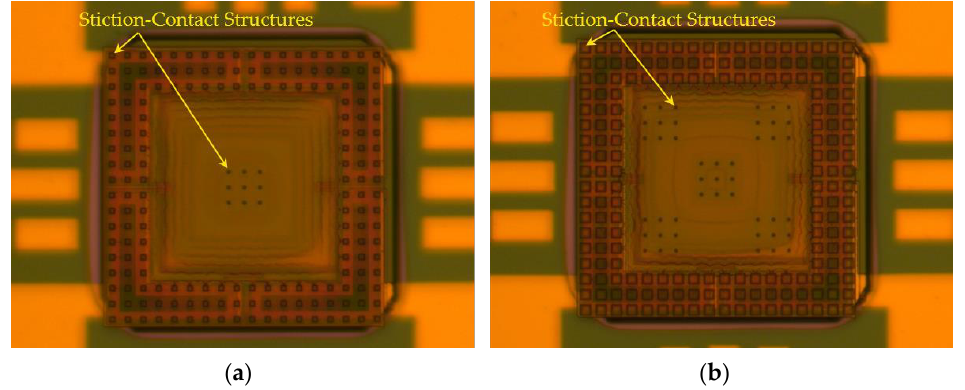
Figure 10. Optical microscopic view of the transferred devices. ( a ) Transferred device with minimum areas (2916 μm 2 ) of stiction-contact structures; ( b ) Transferred device with maximum areas (9000 μm 2 ) of stiction-contact structures.